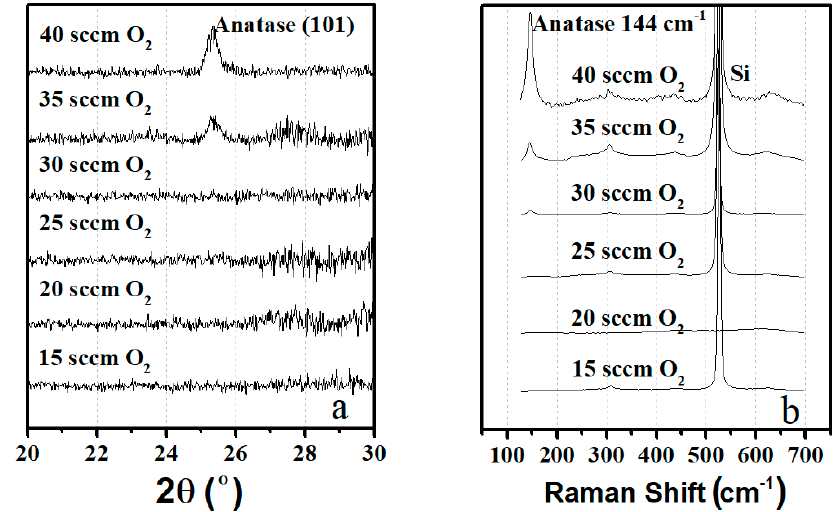
Figure 7. X-Ray diffraction (XRD) ( a ) and Raman ( b ) spectra of TiO 2 thin films deposited under various oxygen flows at 3 kW microwave power.